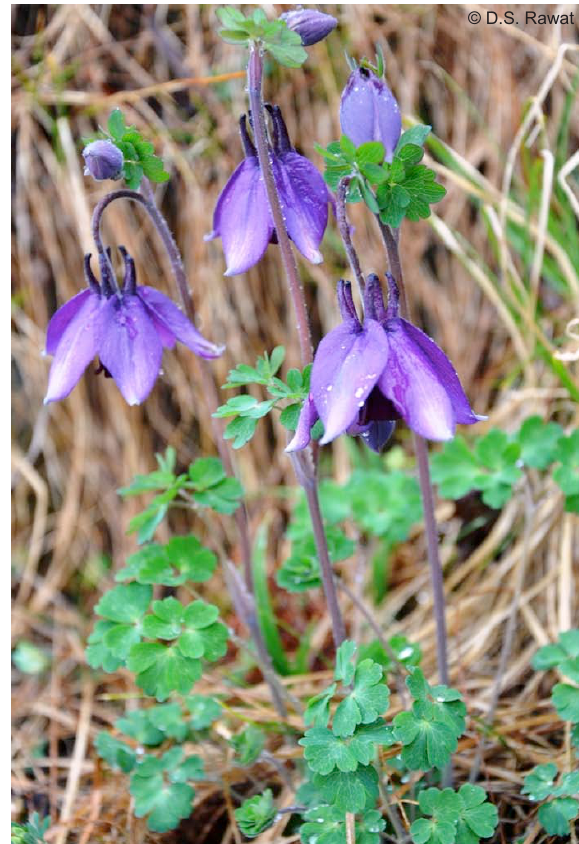
Image 2. Aquilegia